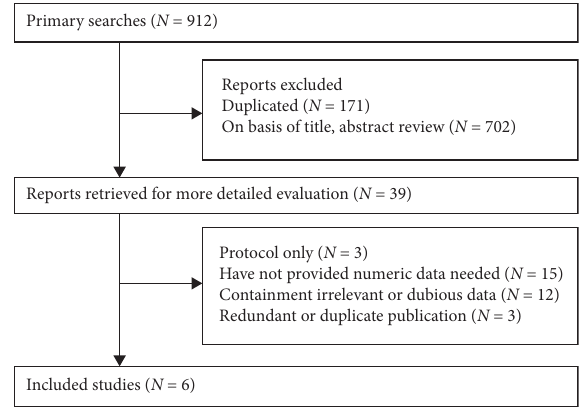
Figure 1: Flowchart of study selection.